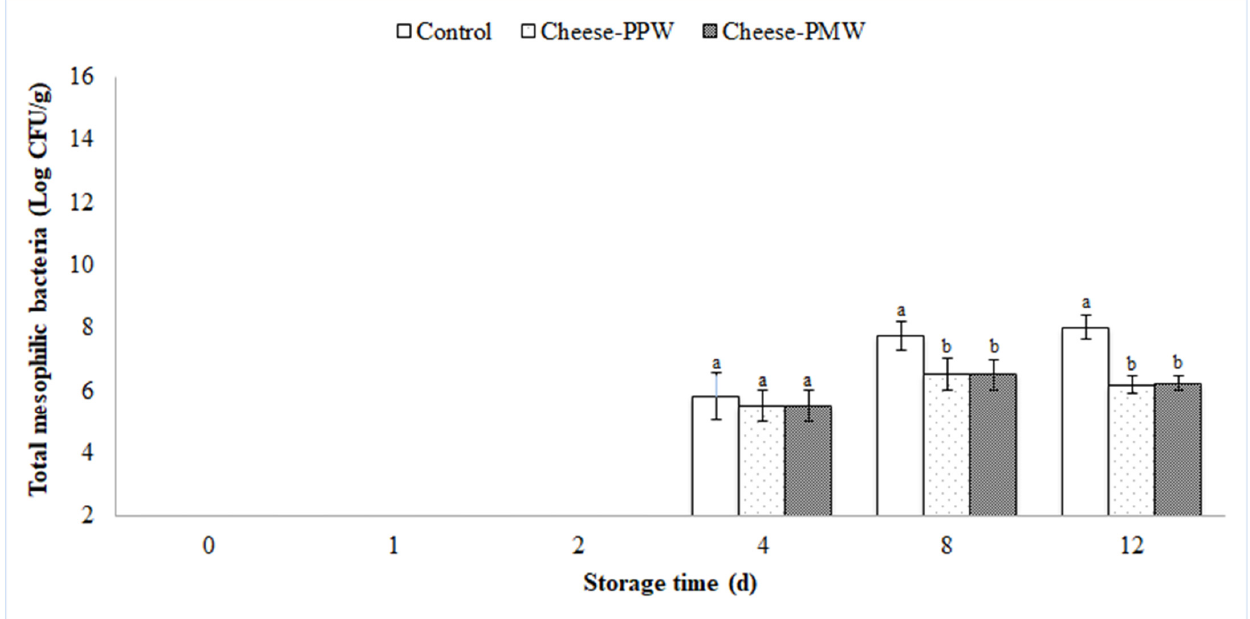
Figure 3. Growth of total mesophilic bacteria (TMB), evaluated up to 12 days of storage at 4 ± 1 °C on control cheese and cheese incorporating pomegranate extracts (cheese–PPW and cheese–PMW). Columns at the same storage time (0, 2, 4, and 8 days) followed by different letters are significantly different according to Fisher’s least significant difference test ( p < 0.05). Vertical bars indicate the standard deviation of the mean.